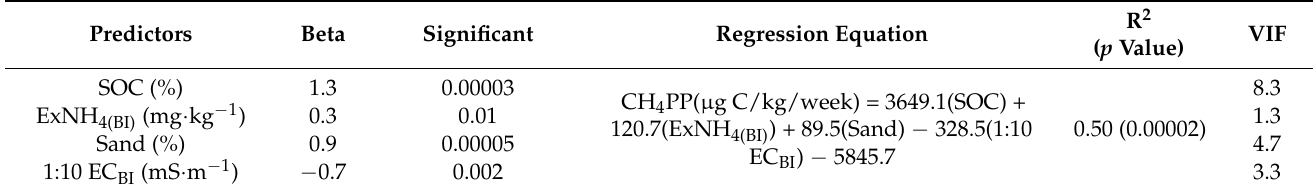
Table 3. Significant predictors in the regression before incubation (BI).